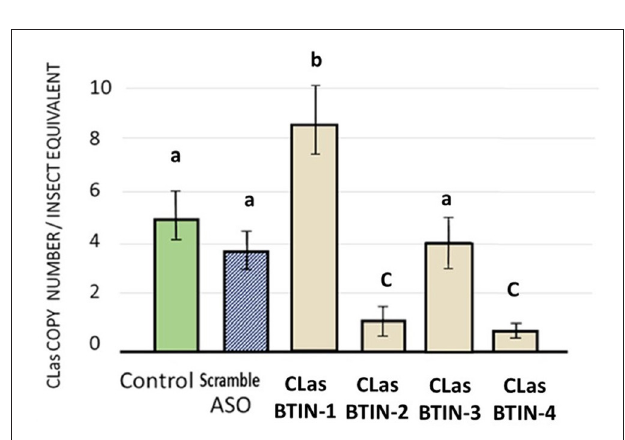
FIGURE 4 | Effects of ingested FANA ASO by CLas-infected adult psyllid targeting CLas acetyl-CoA carboxylase biotin carboxylase subunit (CLas-BTIN). There was a statistically significant difference between group means as determined by one-way ANOVA [ F (3,32) = 8.52, p = 0.0003], followed by post-hoc comparison of means used LSD test ( P ≤ 0.05). Two out of four FANA ASO, designed to (CLas-BTIN) produced significant reduction of CLas in the CLas-infected adult psyllid given a 6-day feeding access period on citrus leaf disks. FANA CLasBTIN-2 and CLasBTIN-4 reduced bacteria concentrations by 3.5- to 3.7-fold less bacteria, respectively, compared to the untreated control. Error bars represent ± SE of the mean from six biological replicates, from three replicates. Bars with the same letter are not significantly